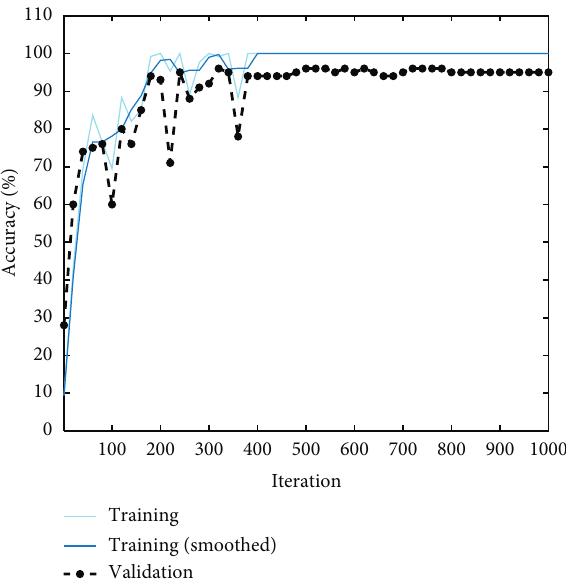
Figure 10: Learning error and accuracy rates during training process.